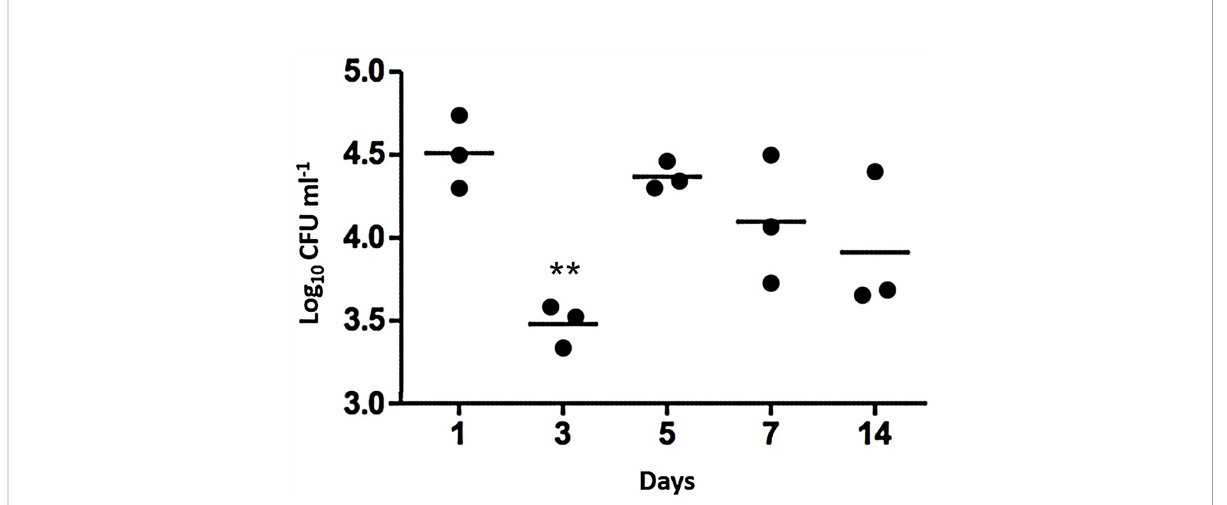
FIGURE 1 Nasopharyngeal colonization of mice by S. aureus USA300 LAC JE2. Intranasal inoculation with ~5 x 104 CFU. At each time point post- inoculation, the colonizing bacteria were recovered and cultured to identify S. aureus . Bars represent mean values of the mice in each time group. 2-way ANOVA was used for statistics with ** indicating